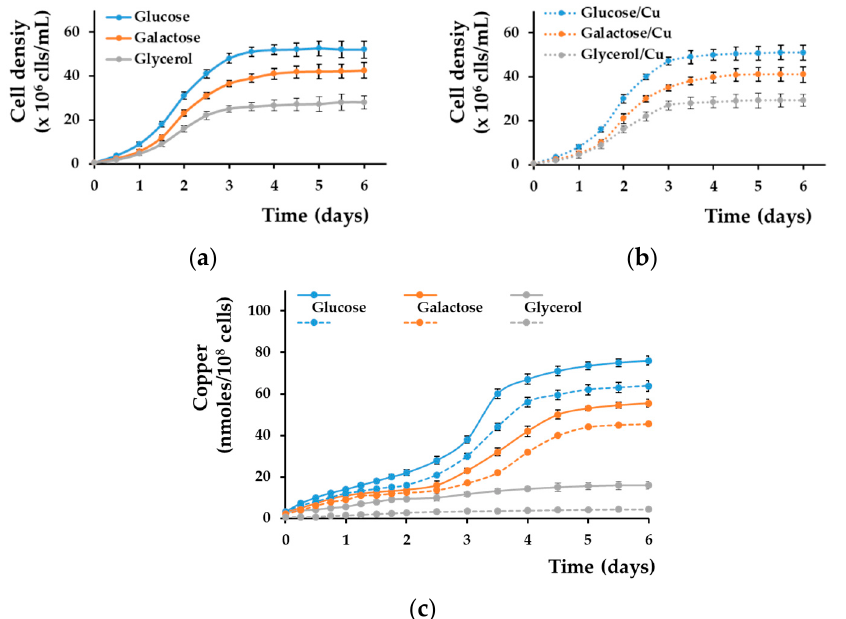
Figure 3. Copper accumulation by yeast cell grown statically in MM liquid media. Cell suspensions of wild-type strain BY4741 were inoculated (5 × 10 5 cells/mL) in MM/Glc (Glucose), MM/Gal (Galactose), or MM/Gly (Glycerol), and cell proliferation was determined spectrophotometrically (OD 660 ) in the absence ( a ) or presence ( b ) of 0.1 mM CuCl 2 . ( c ) Copper associated with whole cells (full lines) or with cell walls (dotted lines) was determined as described in Section 2. Values are mean ± SEM of triplicate determinations done on three biological repeats.